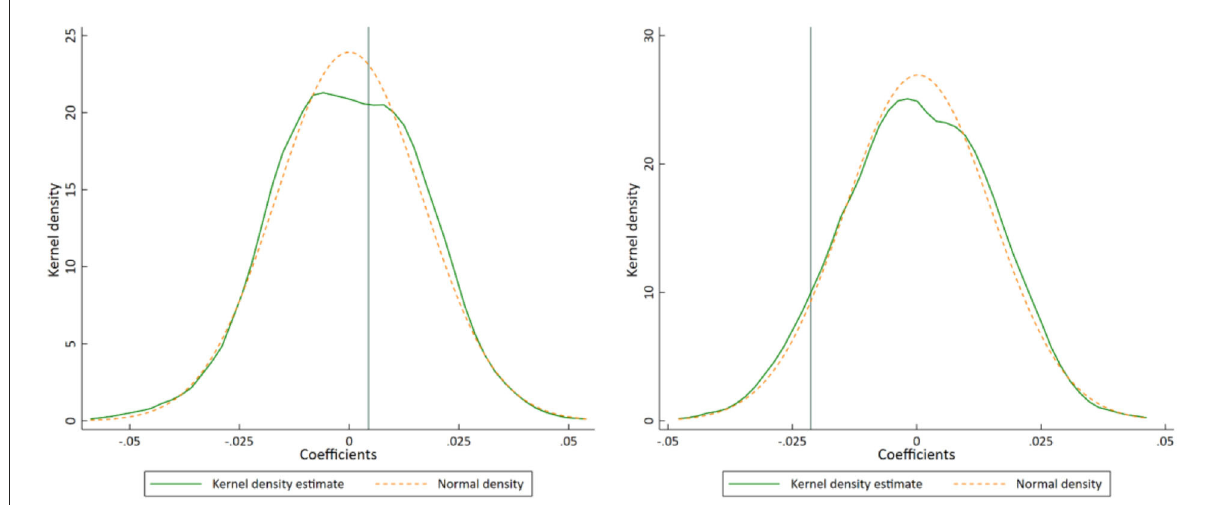
FIGURE5 Placebo test of ln ME_outpatient (left) and ln ME_inpatient (right) . Notes: The teal vertical lines represent the coefficients of the Benchmark regression in Table 3.